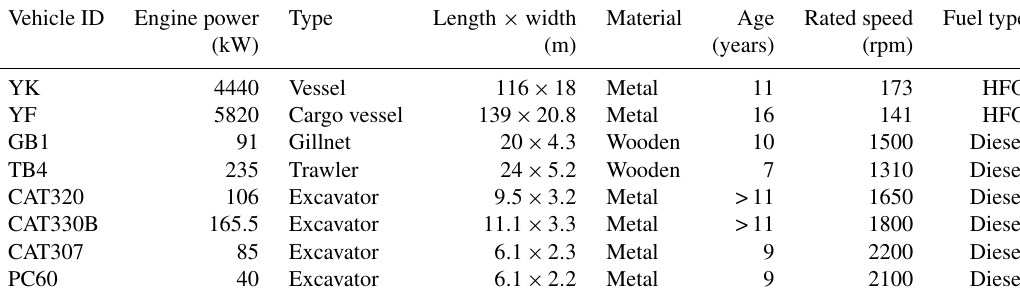
Table 1. Technical parameters of test off-road engines.